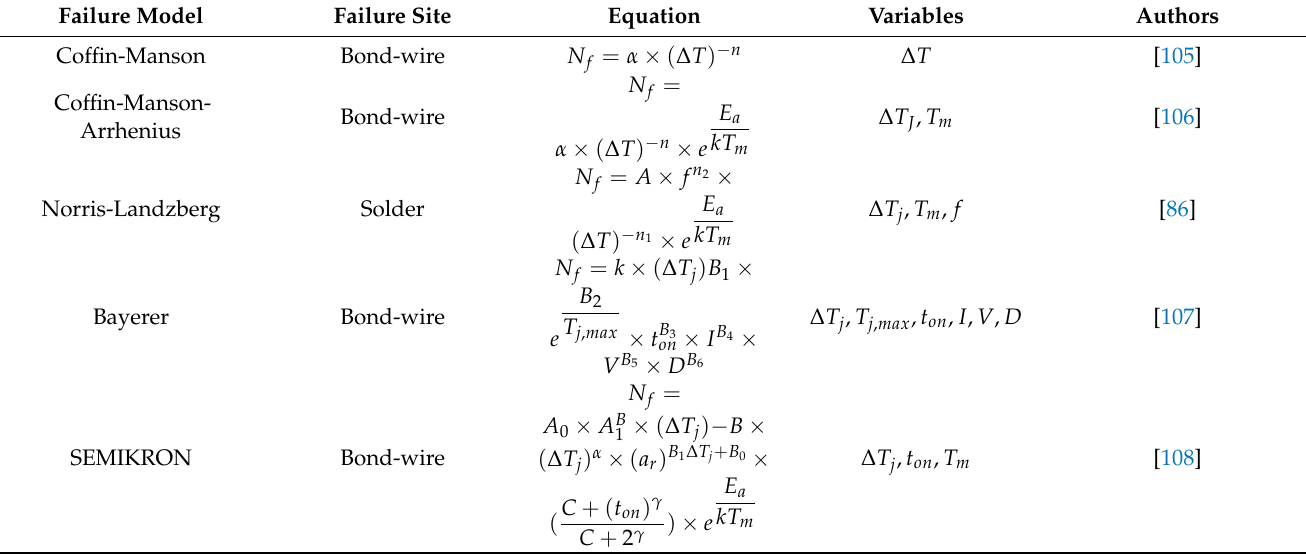
Table 5. Lifetime Models in the